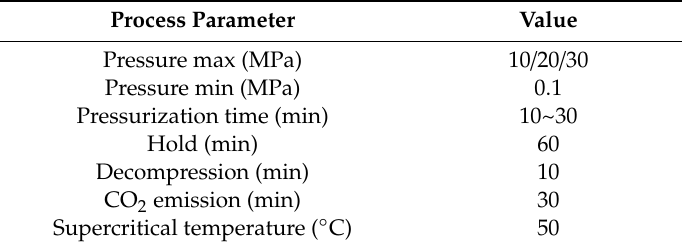
Table 1. Parameters for supercritical CO 2 drying (SCD)